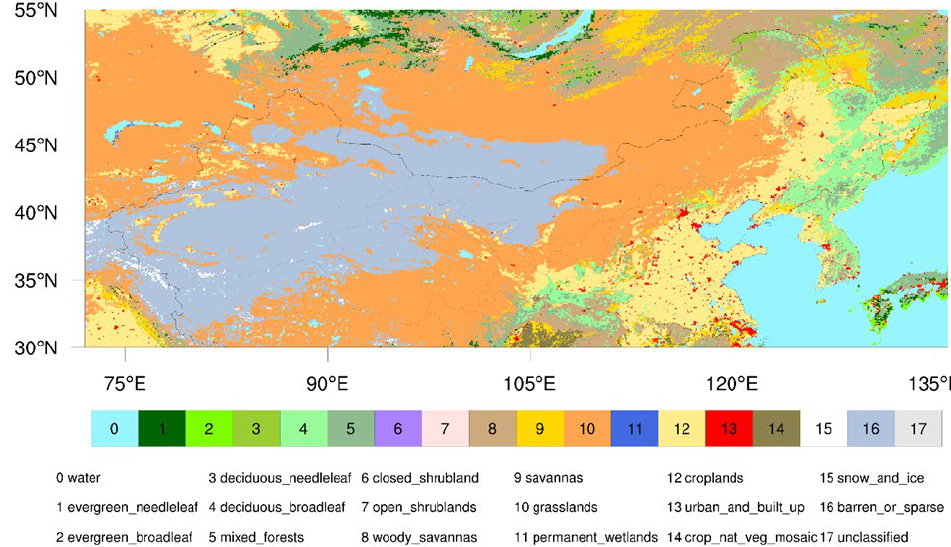
Figure 1. Land cover map of northern China in 2013 derived from the MODIS land cover (MCD12C1 v006) data.